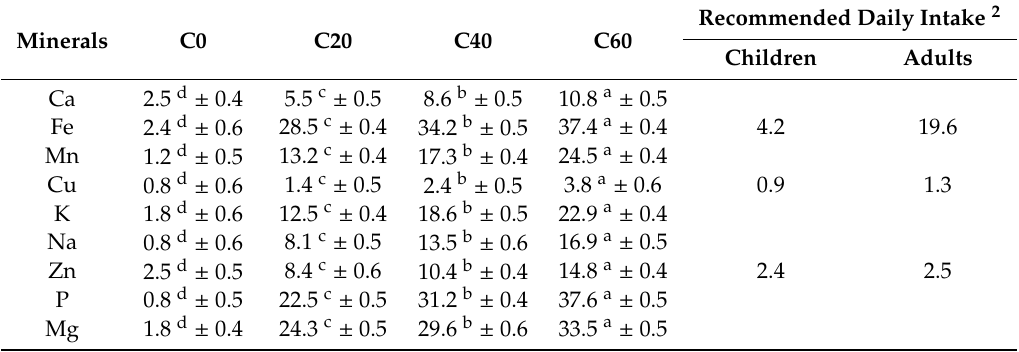
Table 3. Selected mineral elements in cookies fortified with sorghum–termite blend (mg / 100 g) 1.